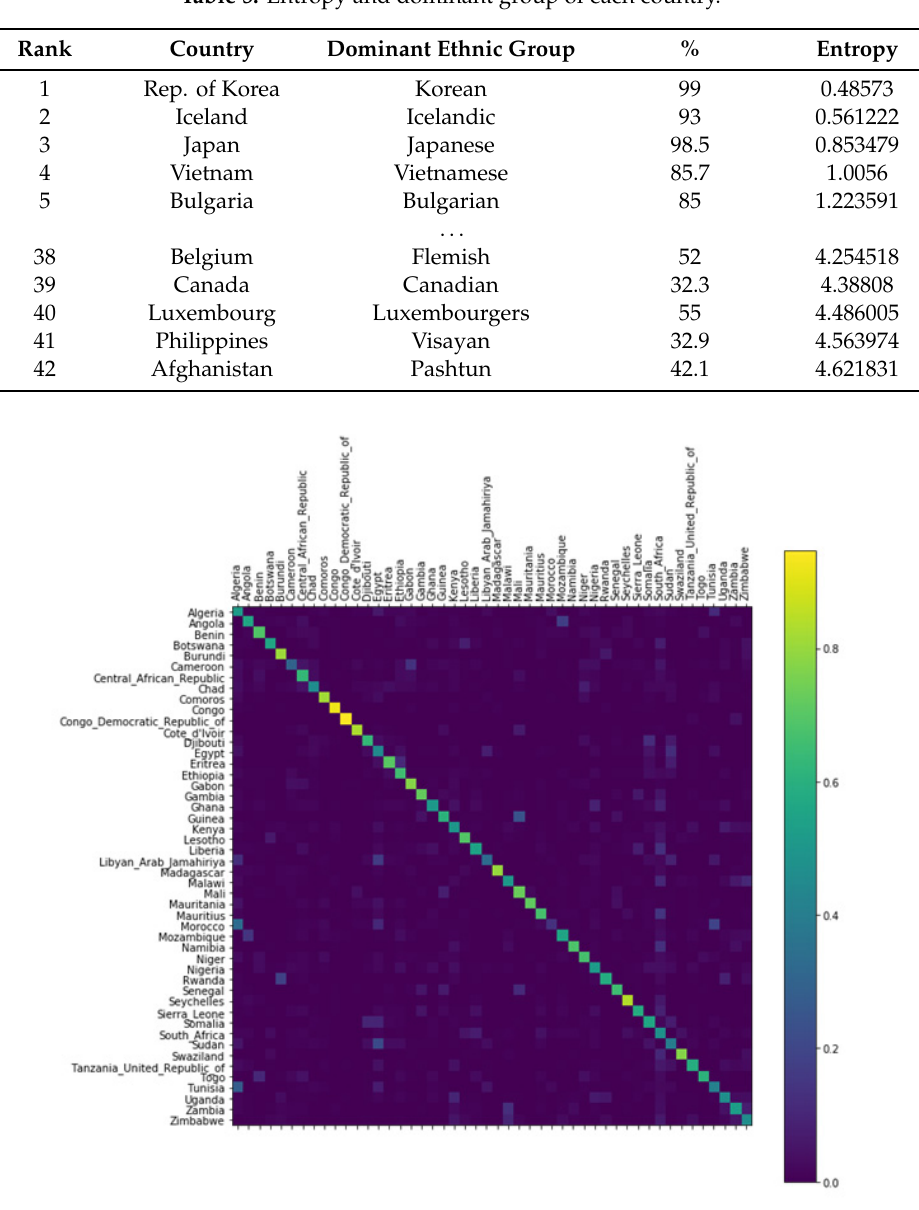
Figure 8. Confusion matrix of African continent; The brighter the color is, the higher is the predicted accuracy of the test